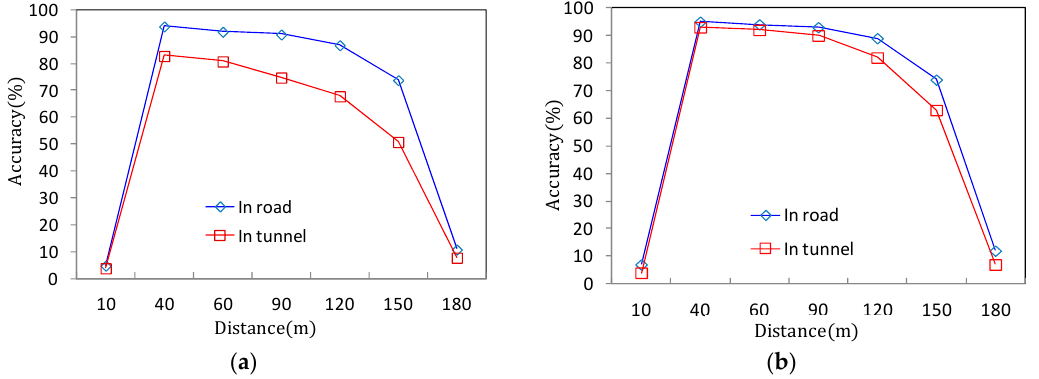
Figure 18. Accident recognition accuracy comparison: ( a ) Accuracy performance according to target distance ( θ = 30 s); ( b ) Accuracy performance according to target distance ( θ = 10 s).